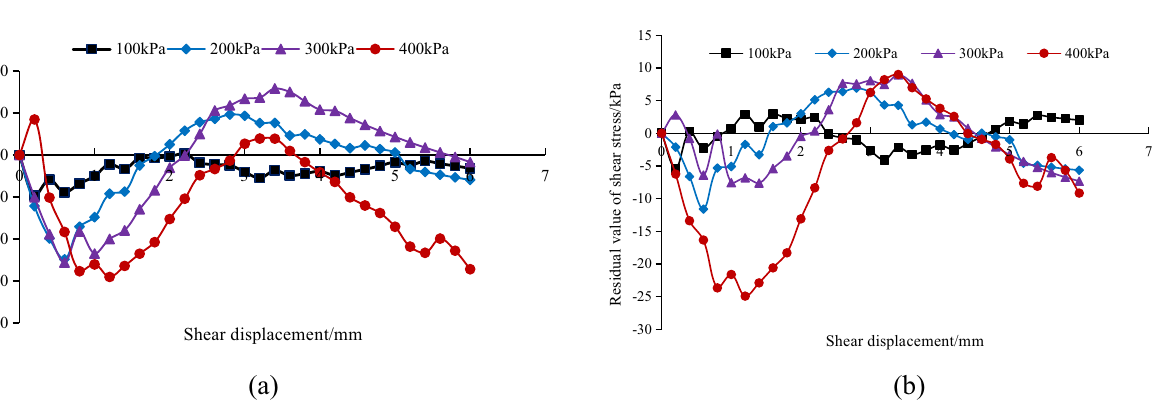
Figure 14. Residual shear stress of interface model under GRS bonding strength. ( a ) The Clough–Duncan curve model; ( b ) the improved Gompertz curve